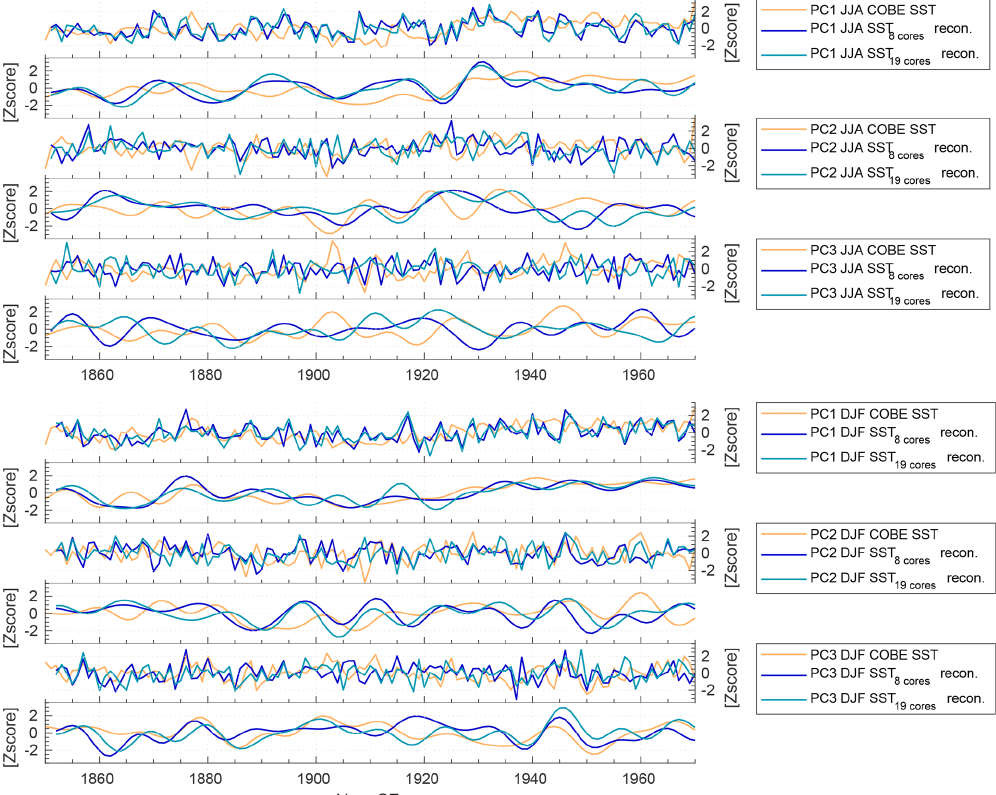
Figure 12. Time series of reconstructed PC1, PC2 and PC3 of SSTs using eight ice cores (dark blue) and 19 ice cores (light blue) compared to PC1, PC2 and PC3 of COBE SSTs (yellow). Smoothed curves are using a decadal FFT filter. Top six plots are for JJA, and bottom six plots are for